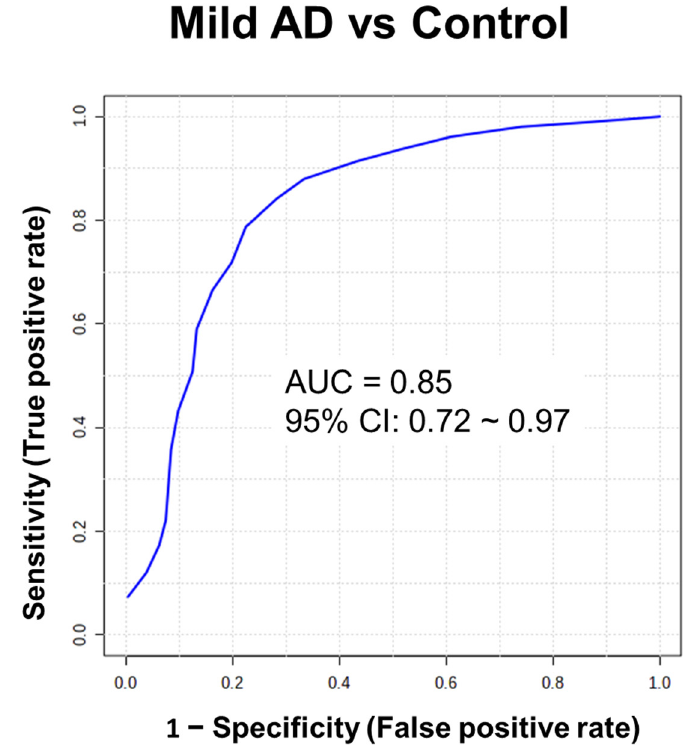
Figure 5. Receiver operator characteristic (ROC) curve analysis of statistically significant metabolites in the hair between patients with AD (CDR score of 0.5) and controls. ROC curve analysis was performed to compare the predictive power of early stage of AD and control with a combination of 9 metabolites using random forest.